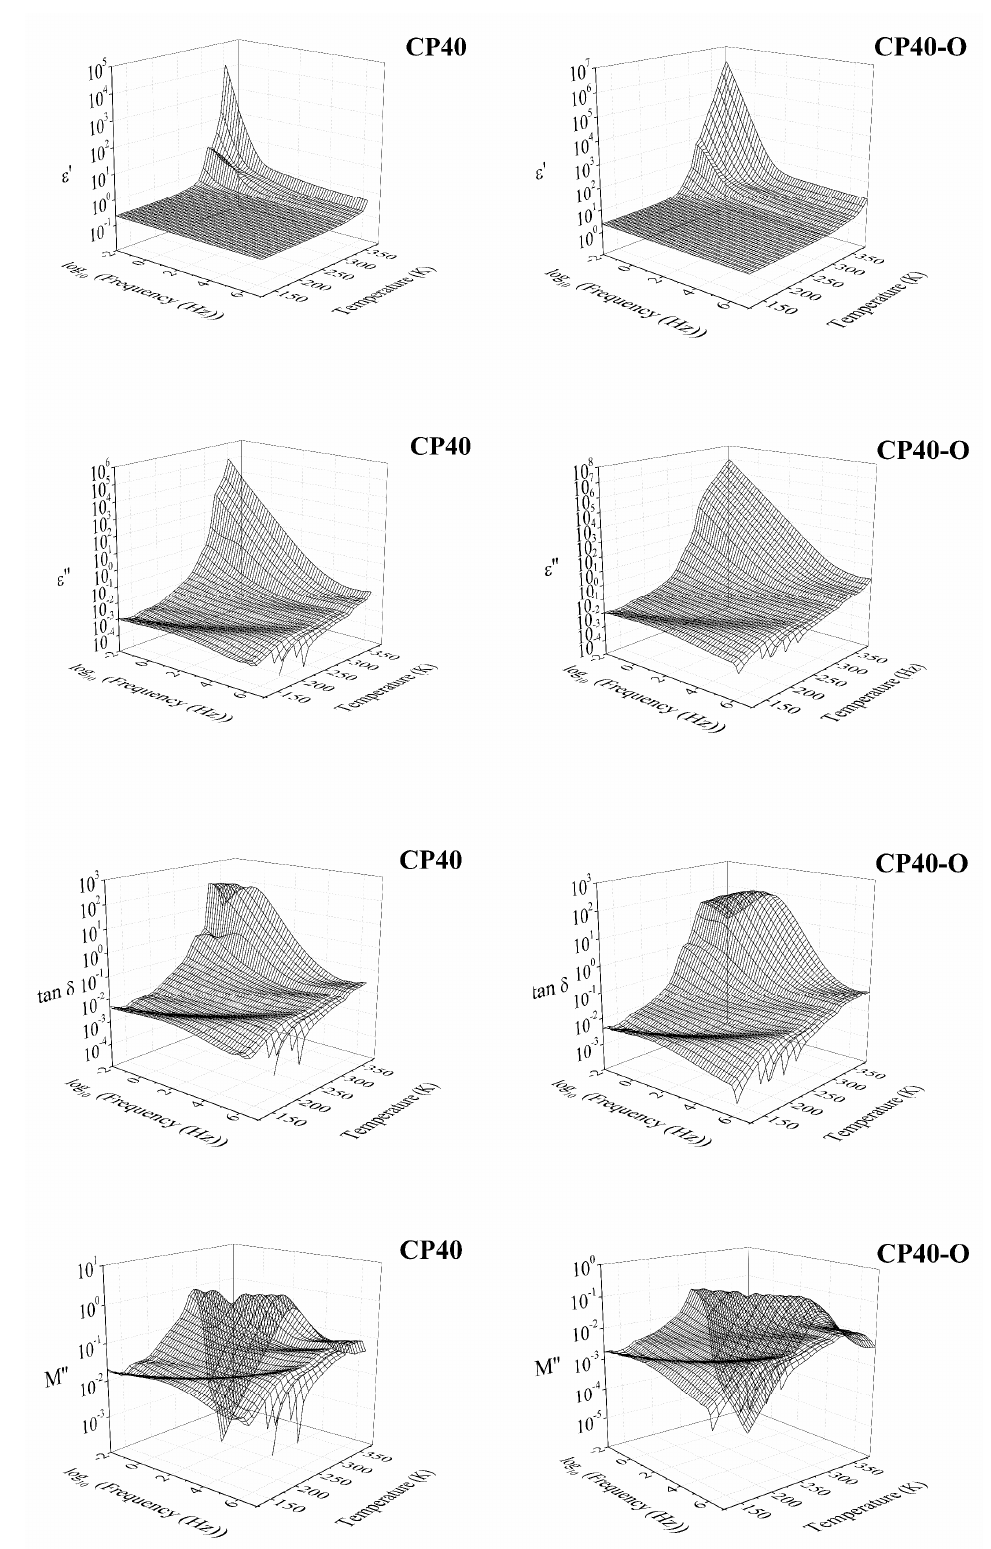
Figure 5. Three-dimensional plot of the dielectric spectra of the CP40 and CP40-O in terms of the real part of the dielectric permittivity ( ε ’ ), the imaginary part of the dielectric permittivity ( ε ” ), the loss tangent (tan δ ), and the imaginary part of the complex electric modulus ( M” ).